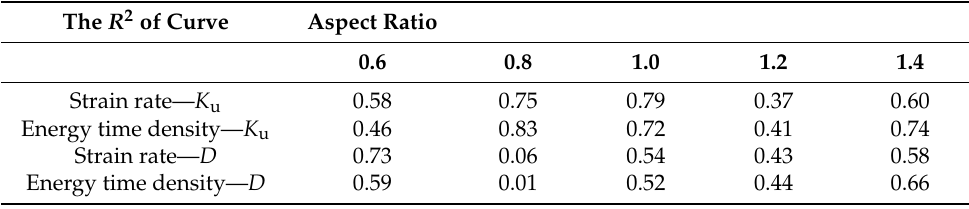
Table 4. The correlation coefficients R 2 of strain rate and energy time density with K u